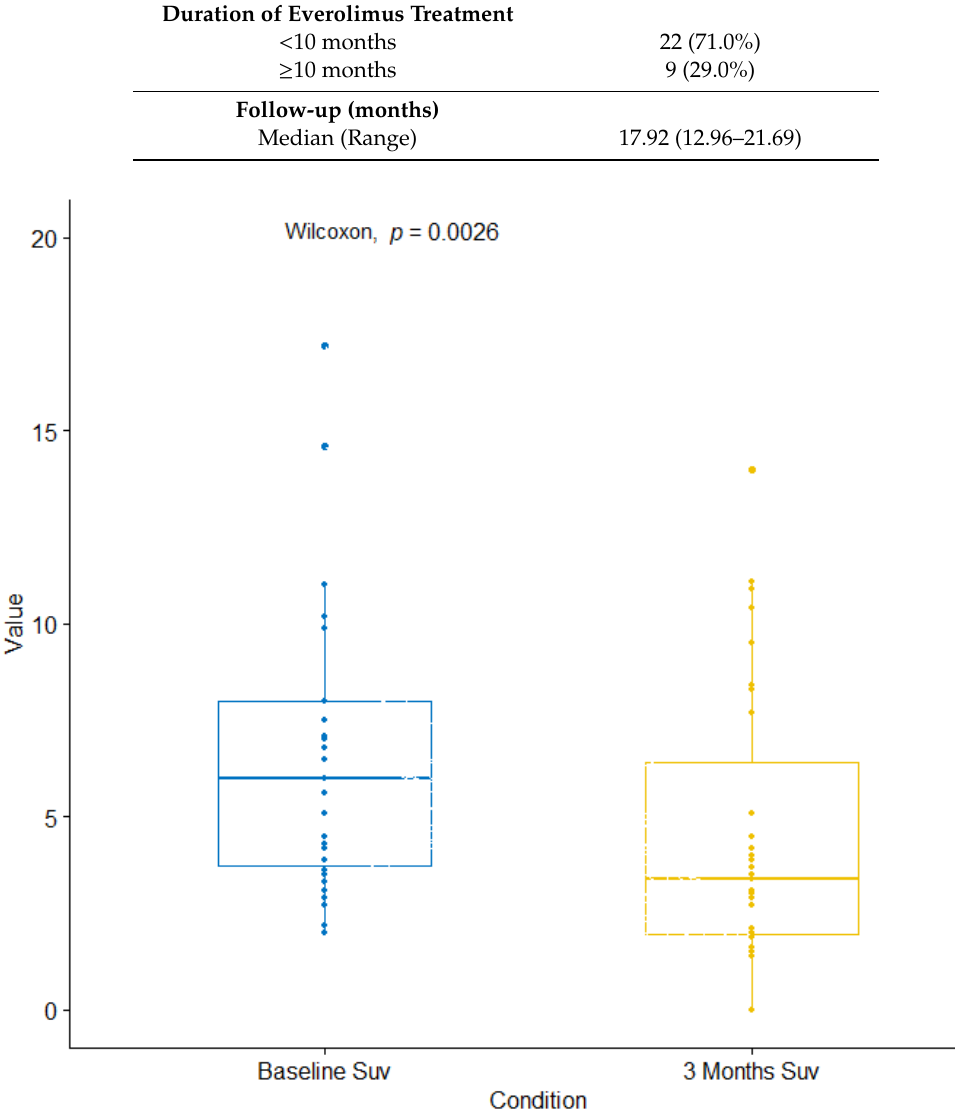
Figure 1. Box plot diagram of distribution of SUV max values at baseline and at 3 months.